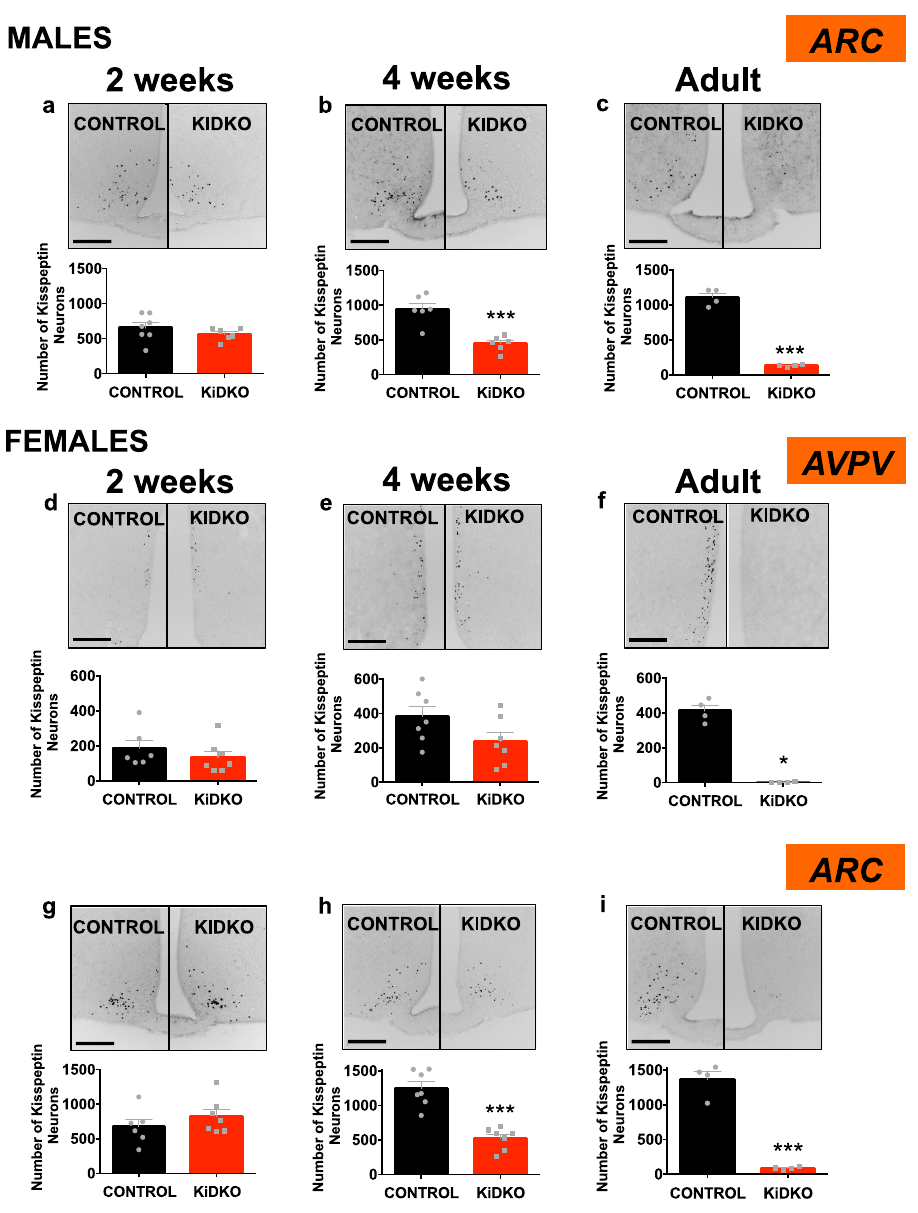
Fig. 3 | Number of GFP-labeled, Kiss1-expressing neurons in KiDKO mice along postnatal maturation. Taking advantage of expression of GFP (tagged to Cre) in Kiss1 neurons of our KiDKO line, GFP-positive (+ve) cells were counted, assuming that, since CreGFP is a non-secreted protein, GFP labeling would provide a more robust maker of viable Kiss1-expressing neurons. Representative images and quantitativedataonGFP+vecellsintheARCofmales( a – c ),andtheAVPV( d – f ),and ARC ( g – i ) of females, of control and KiDKO genotypes, are presented. Data were collectedatthreepostnatalages:2weeks(correspondingtomini-puberty),4weeks (corresponding to early pubertal transition), and adulthood (4 months). Group